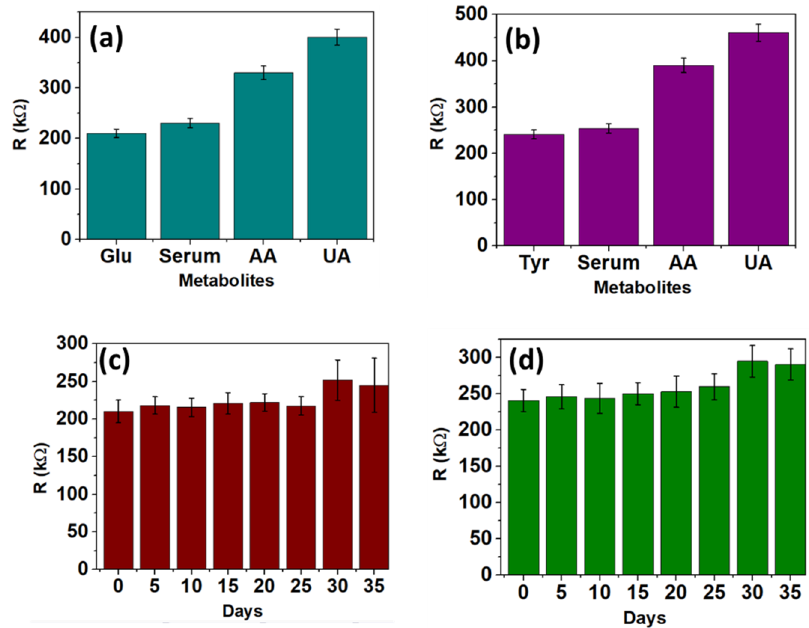
Figure 7. Effect of potential interferants towards the detection of ( a ) glucose; ( b ) tyrosine. The bar “Serum” indicates a mixture of target analytes with interferants spiked in human serum. Shelf-life analysis indicating stability of sensor towards ( c ) glucose; ( d ) tyrosine detection.